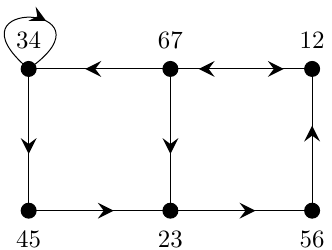
Figure 3: The Markov graph Γ( X, σ ) for the pair ( X, σ ) from Example